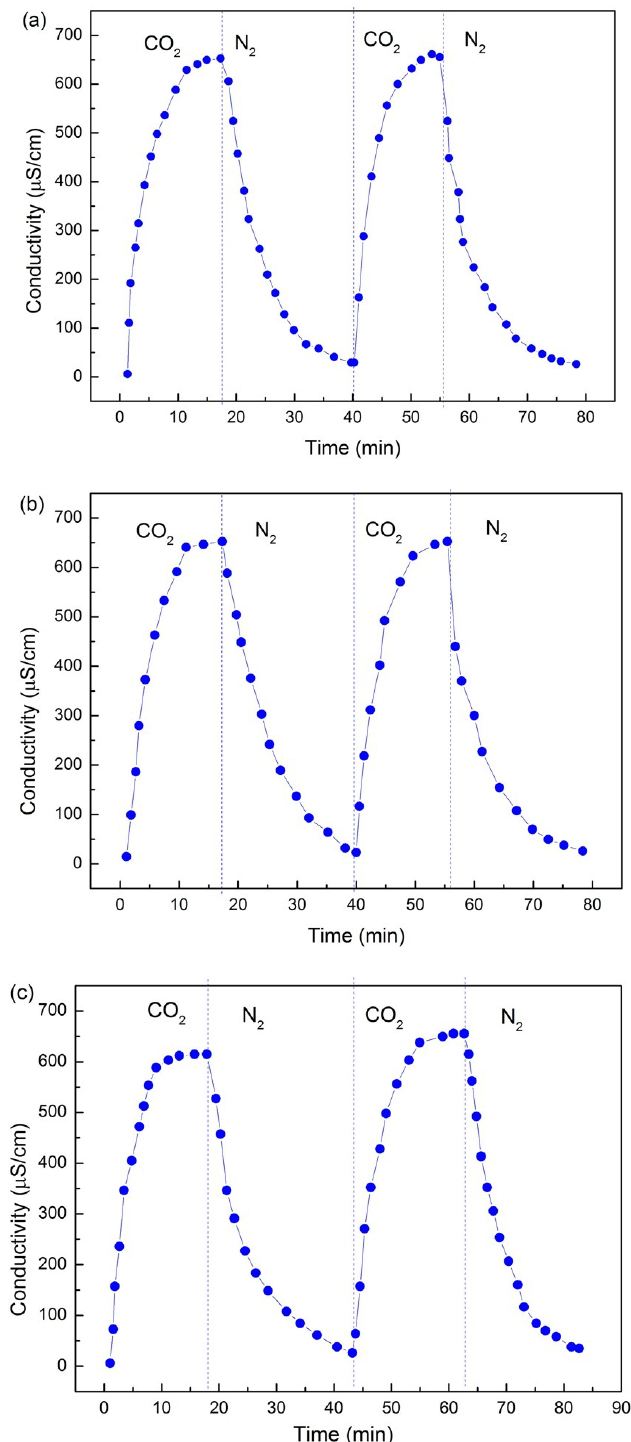
Figure 2. Conductivity of aqueous solutions of polymers 1 ( a ), 2 ( b ), and 3 ( c ) (0.2 wt%) as a function of time during two cycles of CO 2 /N 2 sparging at 25 ± 0.5 °C.